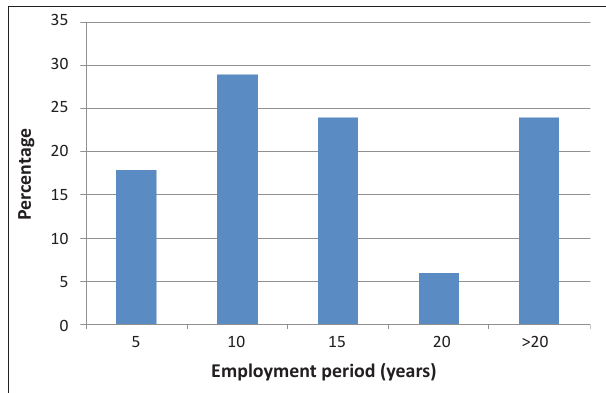
FIGURE 1: Employment period (years).